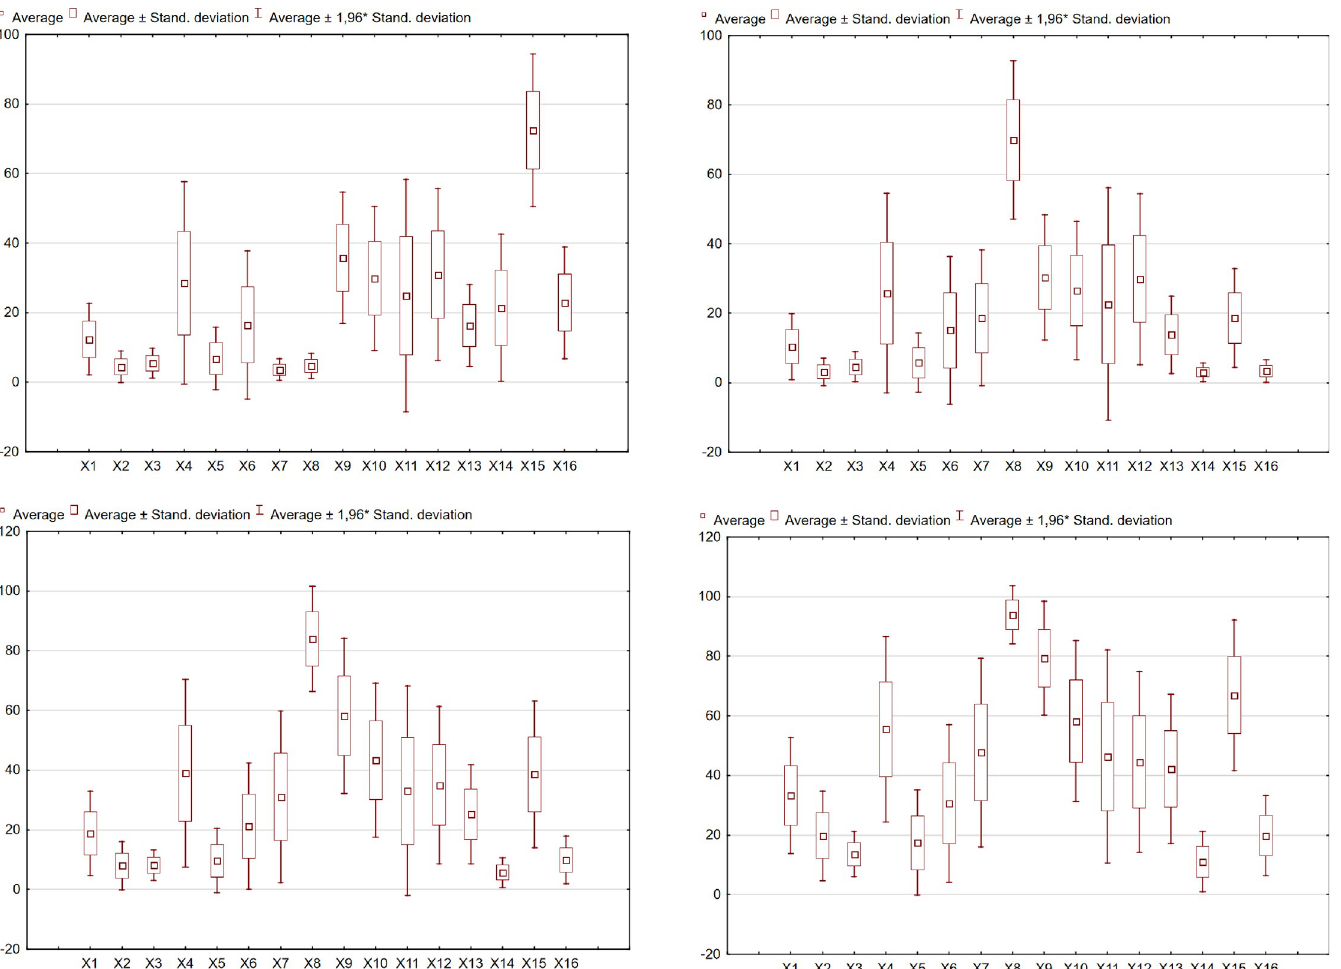
Fig 3. Basic descriptive statistics for the determinants of digitization and robotization of enterprises in the EU27 countries (a-all enterprises, b-small enterprises, c- medium enterprises, d-large enterprises).